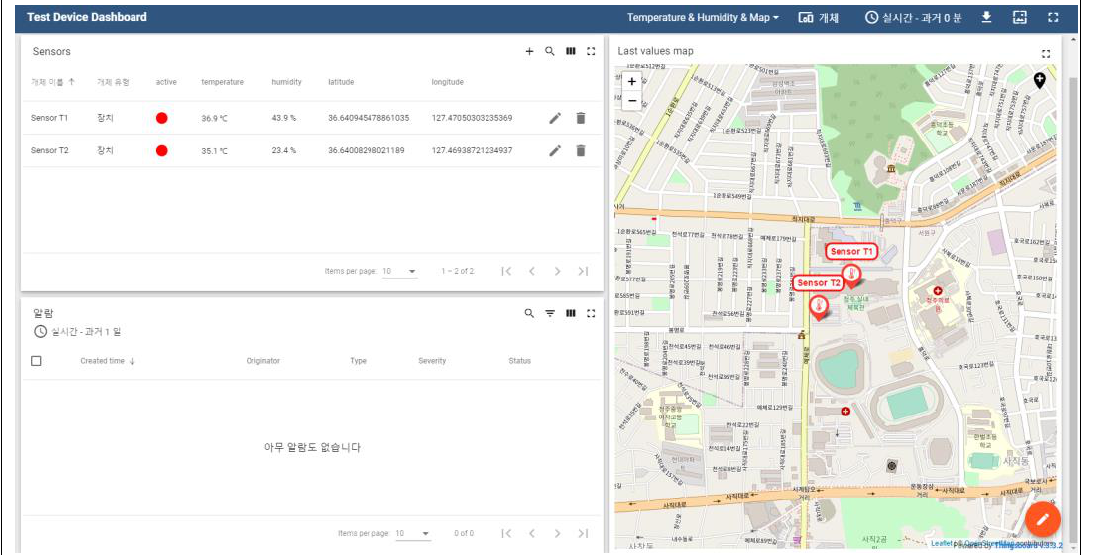
Figure 11. Second dashboard screen captured. (For your information, in this figure, the non-English term “ 장치 ” and the statement “ 아무 알람도 없습니다 ” means “device” and “there are no alar ms” in English, respectively).